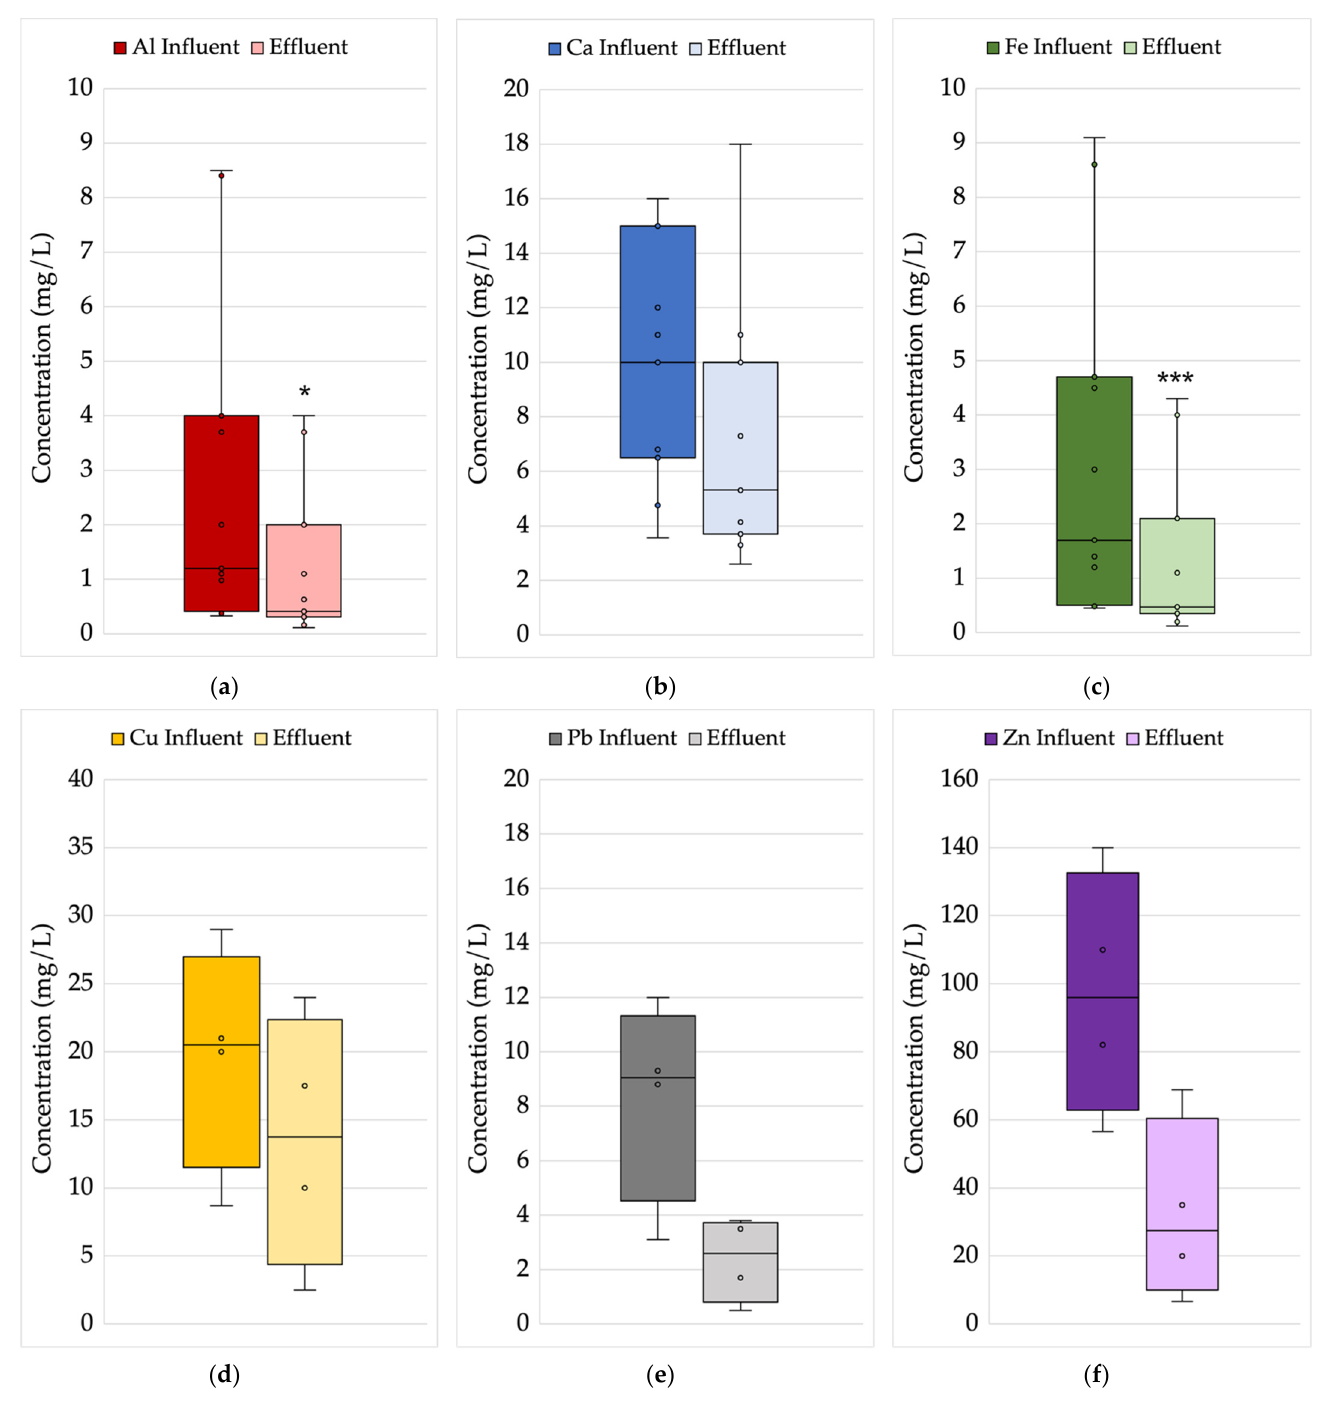
Figure 6. Distribution of event mean concentrations in the influent stormwater and effluent discharge for the metals ( a ) aluminum, ( b ) calcium, ( c ) iron, ( d ) copper, ( e ) lead, and ( f ) zinc. Asterisks represent statistically significant differences in the post-treatment effluent compared to the pre-treatment influent (* = p < 0.05; *** = p < 0.001). If no asterisks are shown, either no significant differences were detected, or the sample size was too small to test for differences.